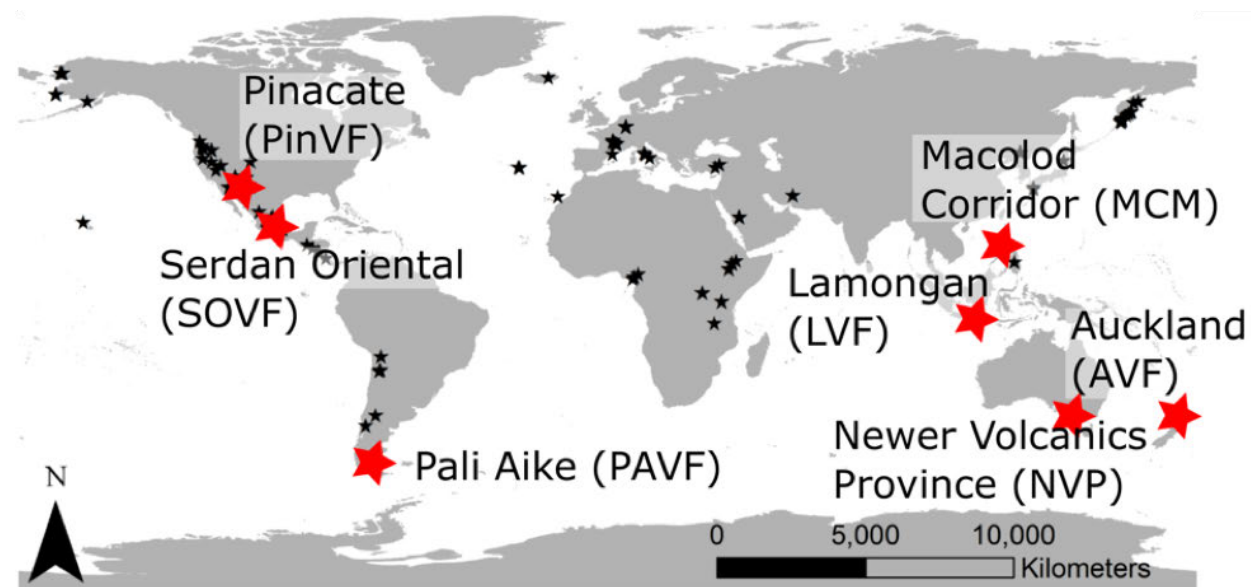
Figure 2: Location of volcanic fields (red stars) in this study overlain on the map of maars in the MaarVLS database (black stars; Graettinger